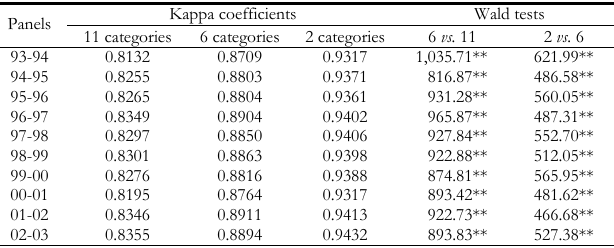
Hierarchical Kappa coefficients and Wald tests: professional